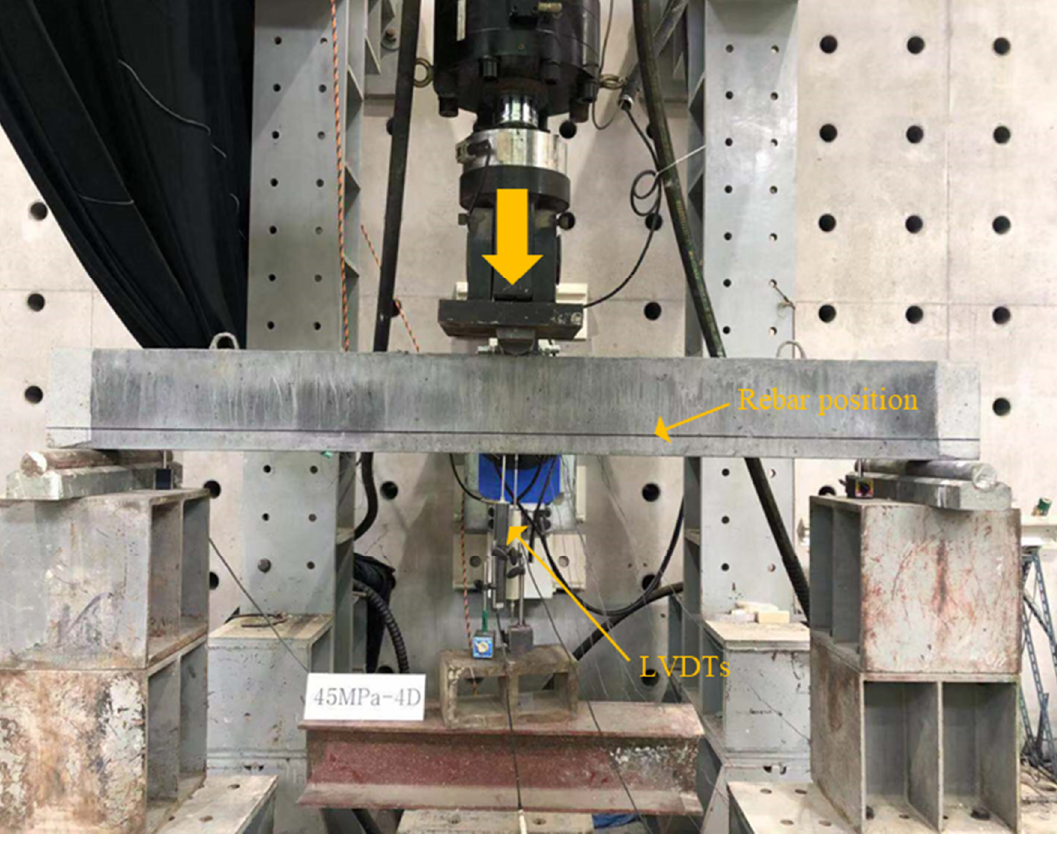
Figure 4. Test set-up of beam flexural strength test.